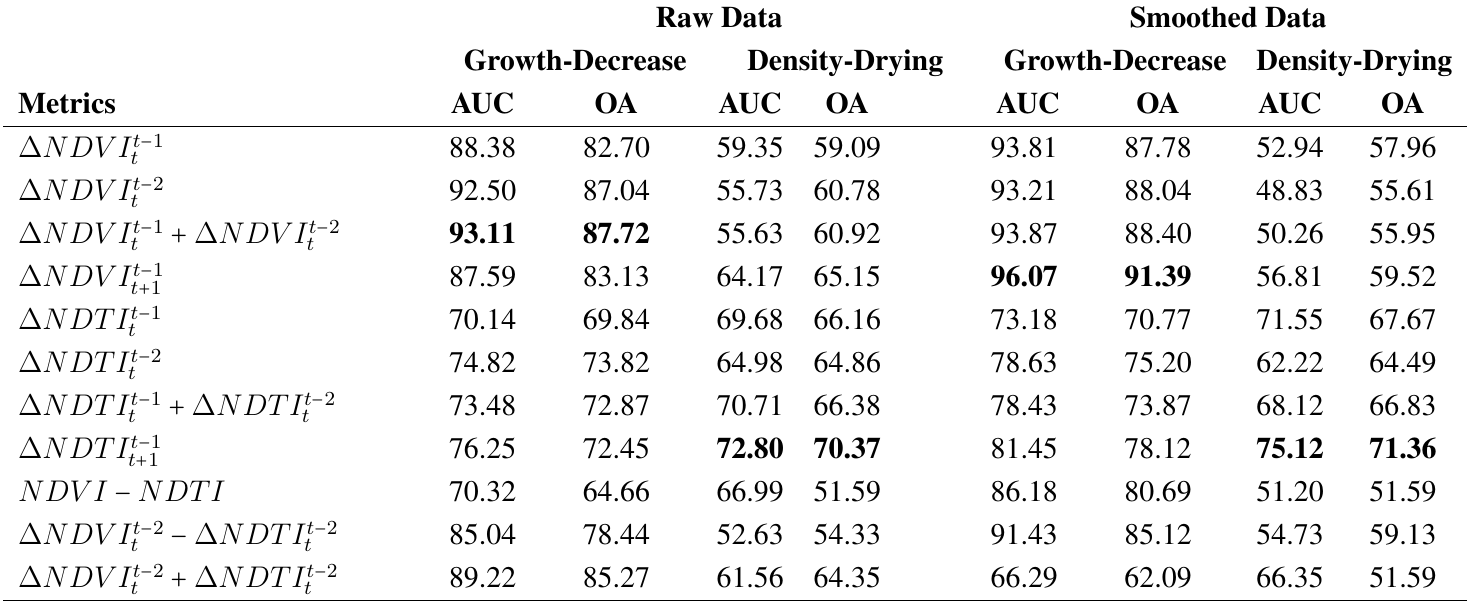
Table 3. Maximum accuracy parameters for the classification using the selected metrics for raw and smoothed data (in percent). The notation “growth-decrease” refers to the discrimination of the categories “growth” and “decrease” (Figure 3a) and “density-drying” to the discrimination of the classes “density reduction” and “drying” (Figure